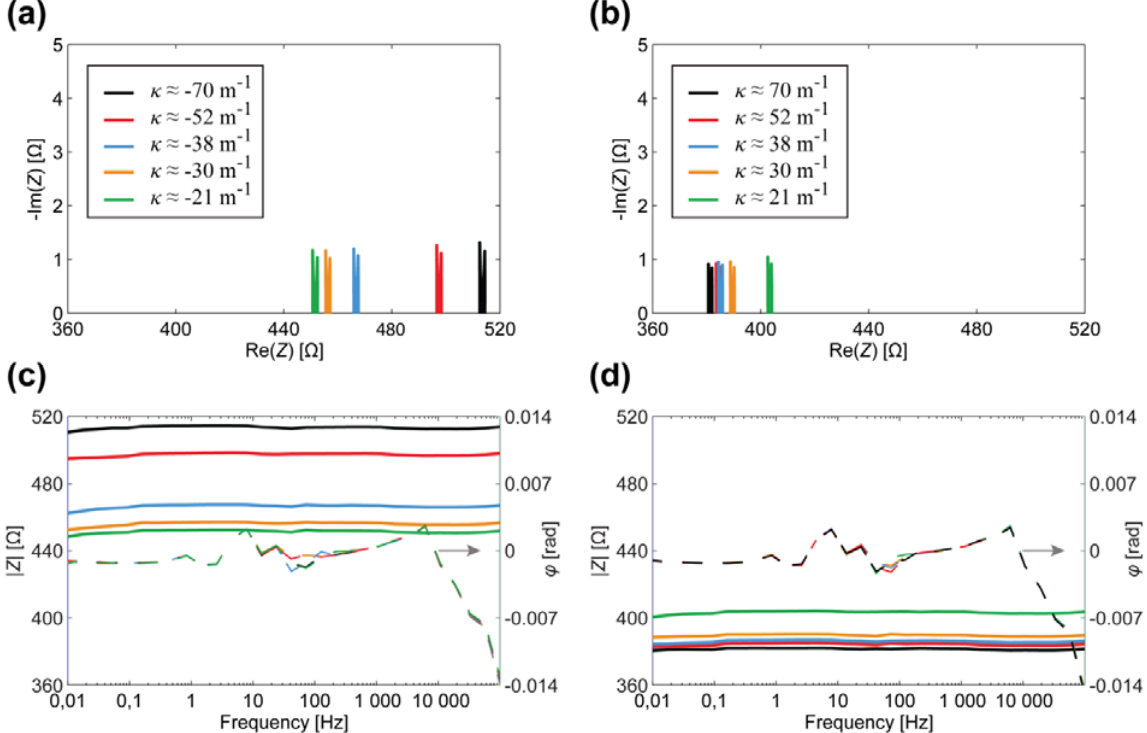
Figure 11. The correlation between the impedance and the curvature of a CDC-based surface electrode. ( a ) Nyquist plot for convex surface electrode; ( b ) Nyquist plot for concave surface electrode; ( c ) Bode plot for convex surface electrode; ( d ) Bode plot for concave surface